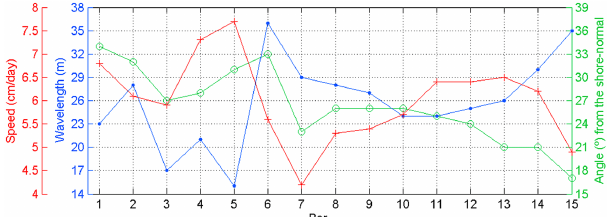
Figure 7. Time-averaged wavelength, angle and migration rate of each bar. The bar angles are measured from the shore normal to the east. Positive values of the bar speeds represent movements of the bars to the